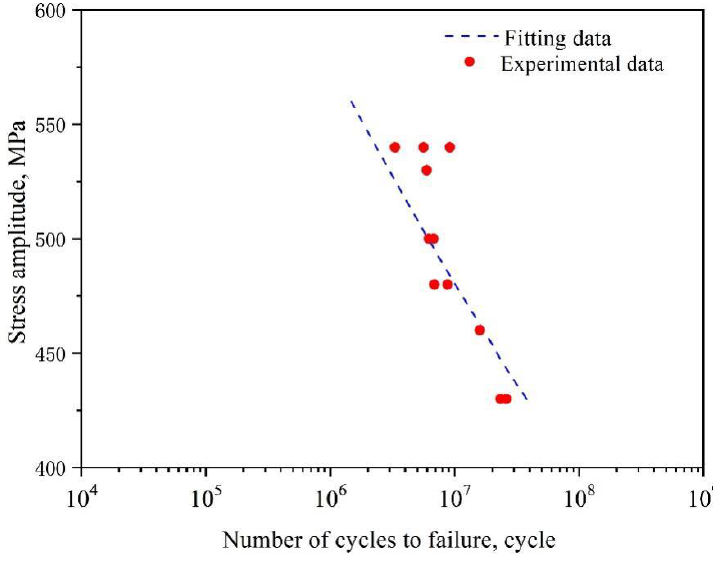
Figure 6. Fitting of fatigue damage parameters for TC21 titanium alloy.